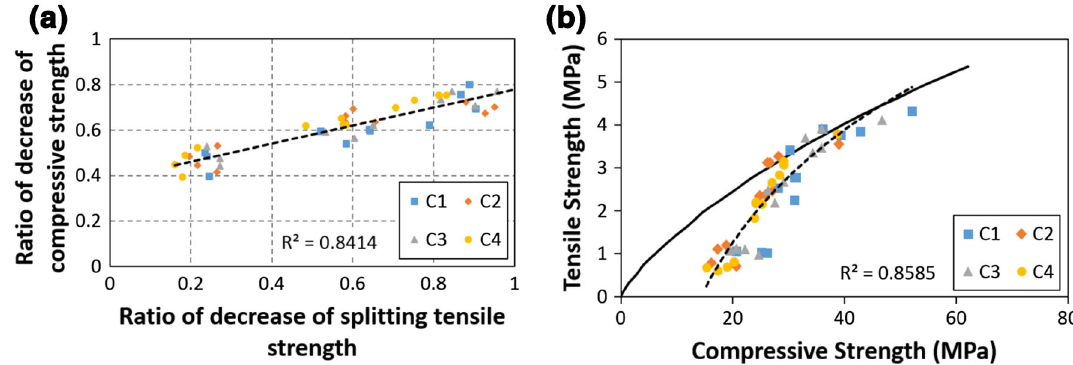
Fig. 9 Relationship between compressive strength and splitting tensile